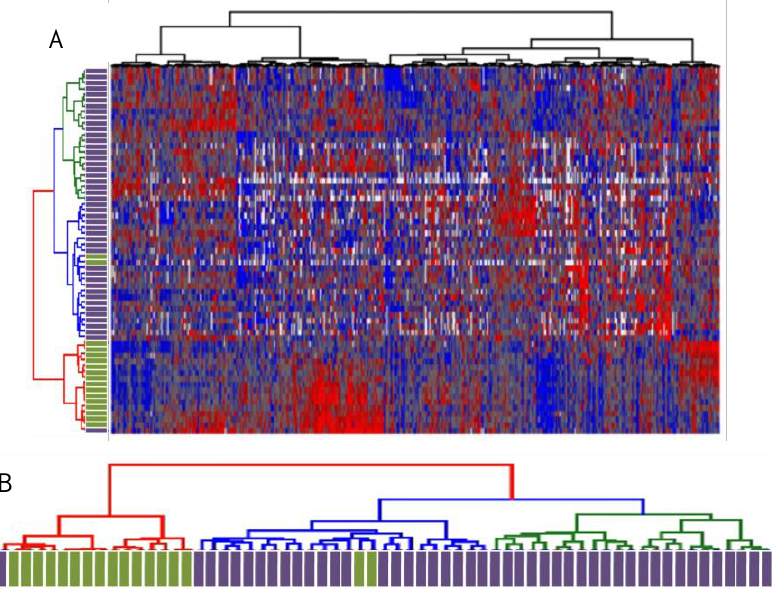
Figure 1. ( A ) Unsupervised hierarchical clustering of 596 highly variable genes. ( B ) Dendrogram depicting separation of MD-OS tumors (green bars) and LD-OS tumors based on expression of highly variable genes. ( A ) Unsupervised hierarchical clustering of OS tumor samples (Partek Genomics Suite) was performed on a subset of 596 genes found to be significantly differentially expressed within the dataset (expression varies by at least 6 fold, in at least 4 patients, p ≤ 0.001), according to methods previously described [13,14]. ( B ) The dendrogram reveals two clusters, one with red dendrogram lines that contains mostly metastatic-at-diagnosis tumors (green rectangles). A second cluster, which can be subdivided further (blue and green dendrogram lines) contains mostly localized-at-diagnosis tumors (purple